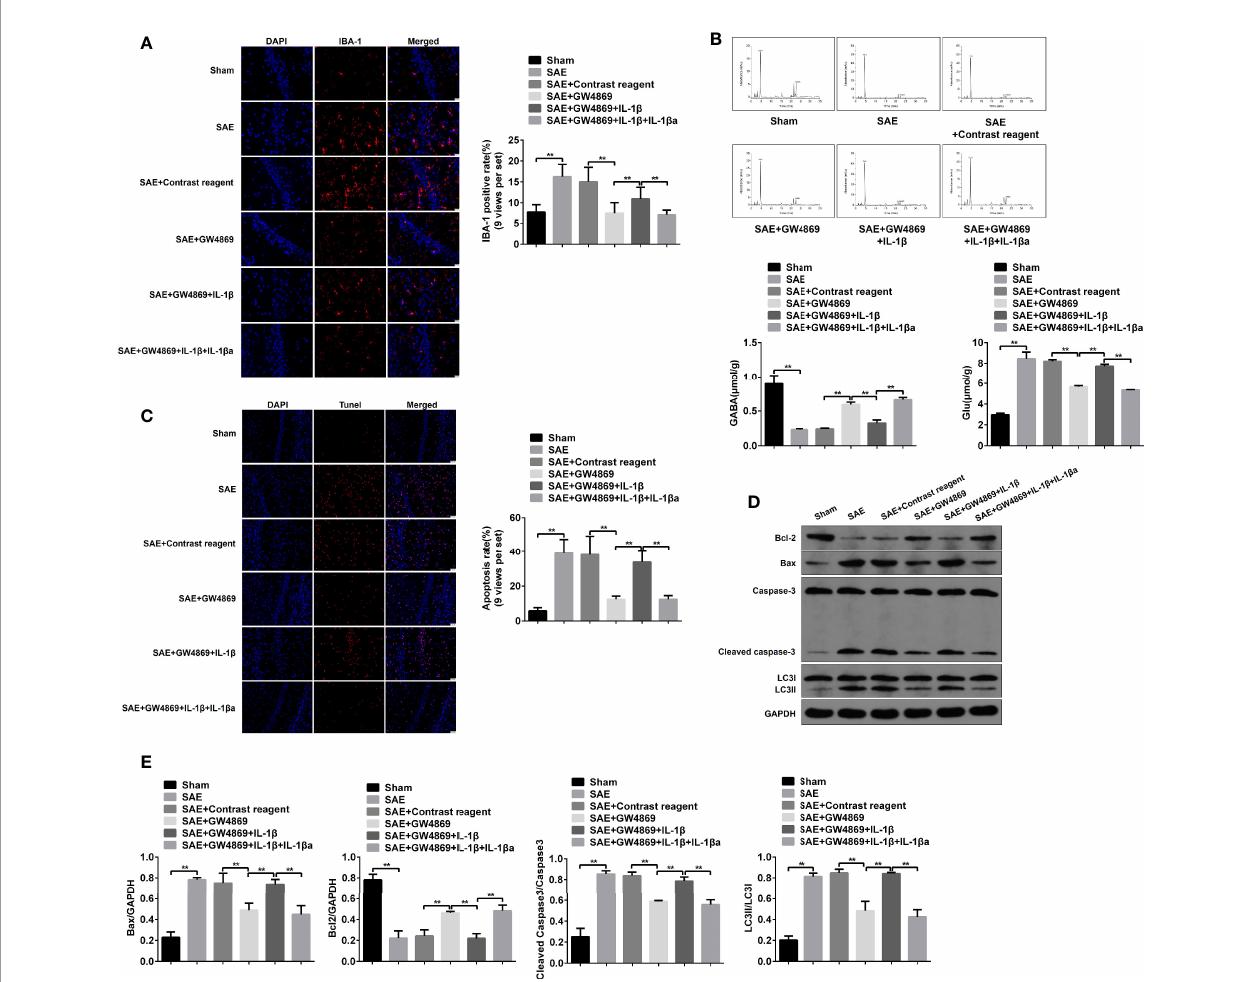
FIGURE 7 | Role of IL-1 b in hippocampus impairment of SAE rats. (A) In hippocampus tissues of Sham-operated, SAE, SAE treated with control reagent, SAE treated with IL-1 b , and SAE treated with IL-1 b and IL-1 b antagonist rats, the expression of IBA-1 in paraf fi n-embedded hippocampus tissues as measured using IF staining. Relative quantitation of IBA-1-positive cells as shown in the right (nine views per set). (B) The concentrations of Glu and GABA were detected by HPLC in the hippocampus tissues. (C) TUNEL assay was employed to determine the apoptotic cells in the hippocampus tissues. Relative quantitation of TUNEL-positive cells as shown in the right (nine views per set). (D) The protein levels of Bcl-1, BAX, cleaved caspase 3, and LC3II/I were detected by WB in the hippocampus tissues. (E) Protein quantitative analysis of Bcl-1, BAX, cleaved caspase 3, and LC3II/I in panel (D) of this fi gure. **P <